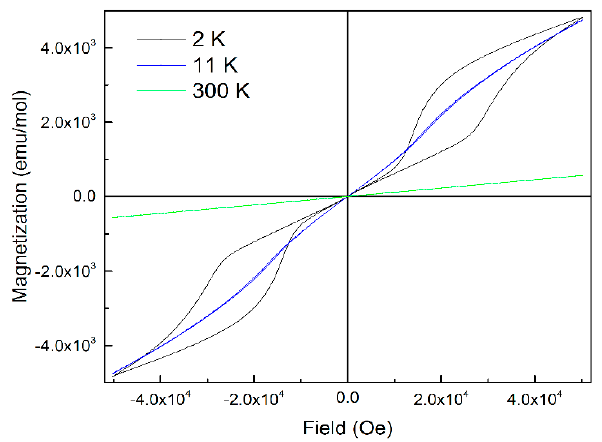
Figure 9. Magnetization as a function of the applied field between 5 and − 5 T measured at 2, 11 and 300 K for the sample of LCP-C mcm (PO).